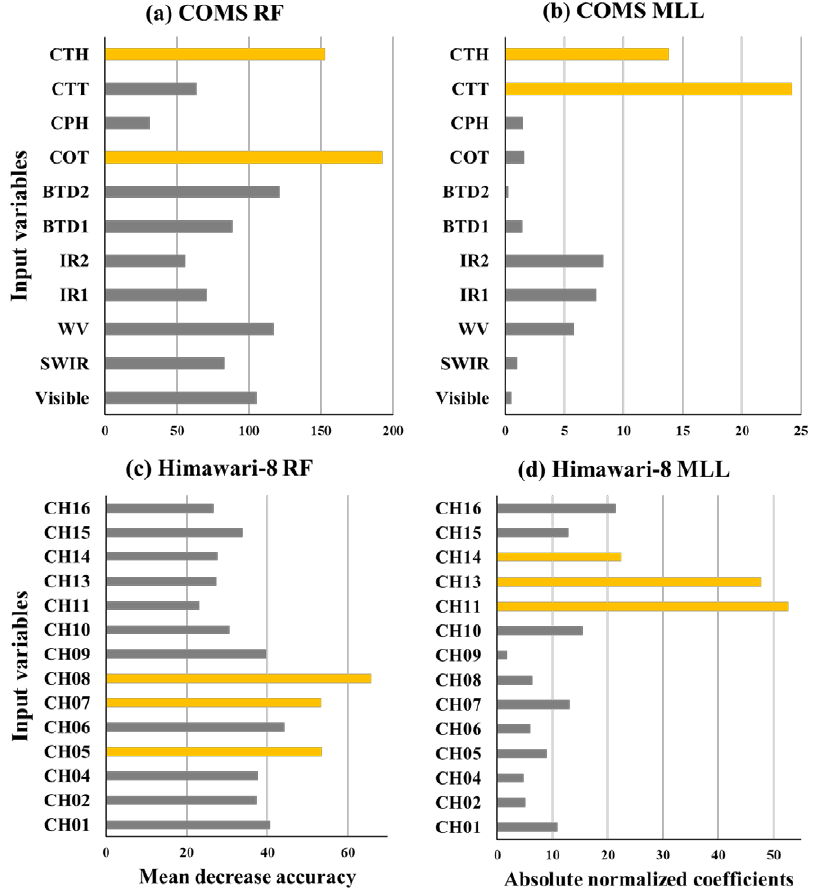
Figure 3. Relative variable importance identified by machine learning models. Mean decrease accuracy is calculated using out-of-bag samples when a variable is perturbed by random forest (RF). Absolute normalized coefficients are considered as a variable importance in the multinomial log-linear (MLL) models. The larger the value of a variable, the more significant the variable. The most significant (top 20%) variables are displayed in orange.